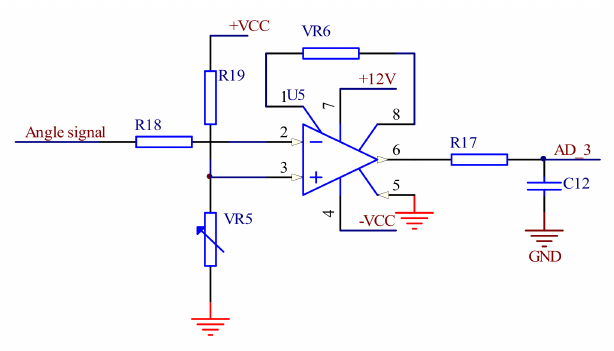
Figure 8. Angle sensing signal preprocessing